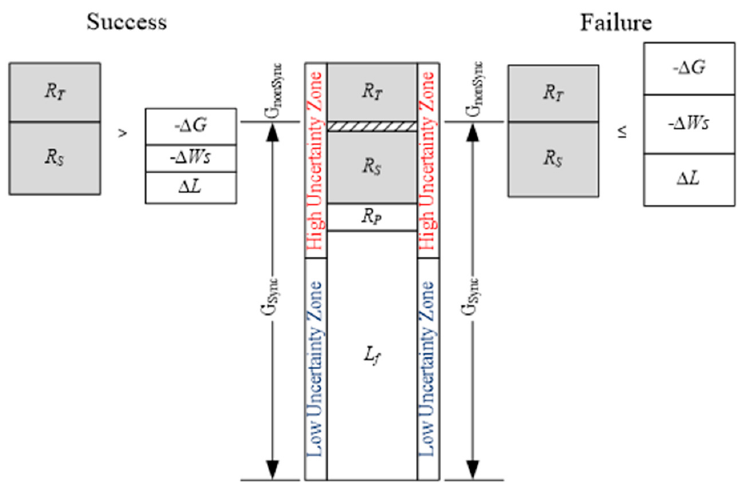
Figure 1. Framework of the operating reserve capacity evaluation.